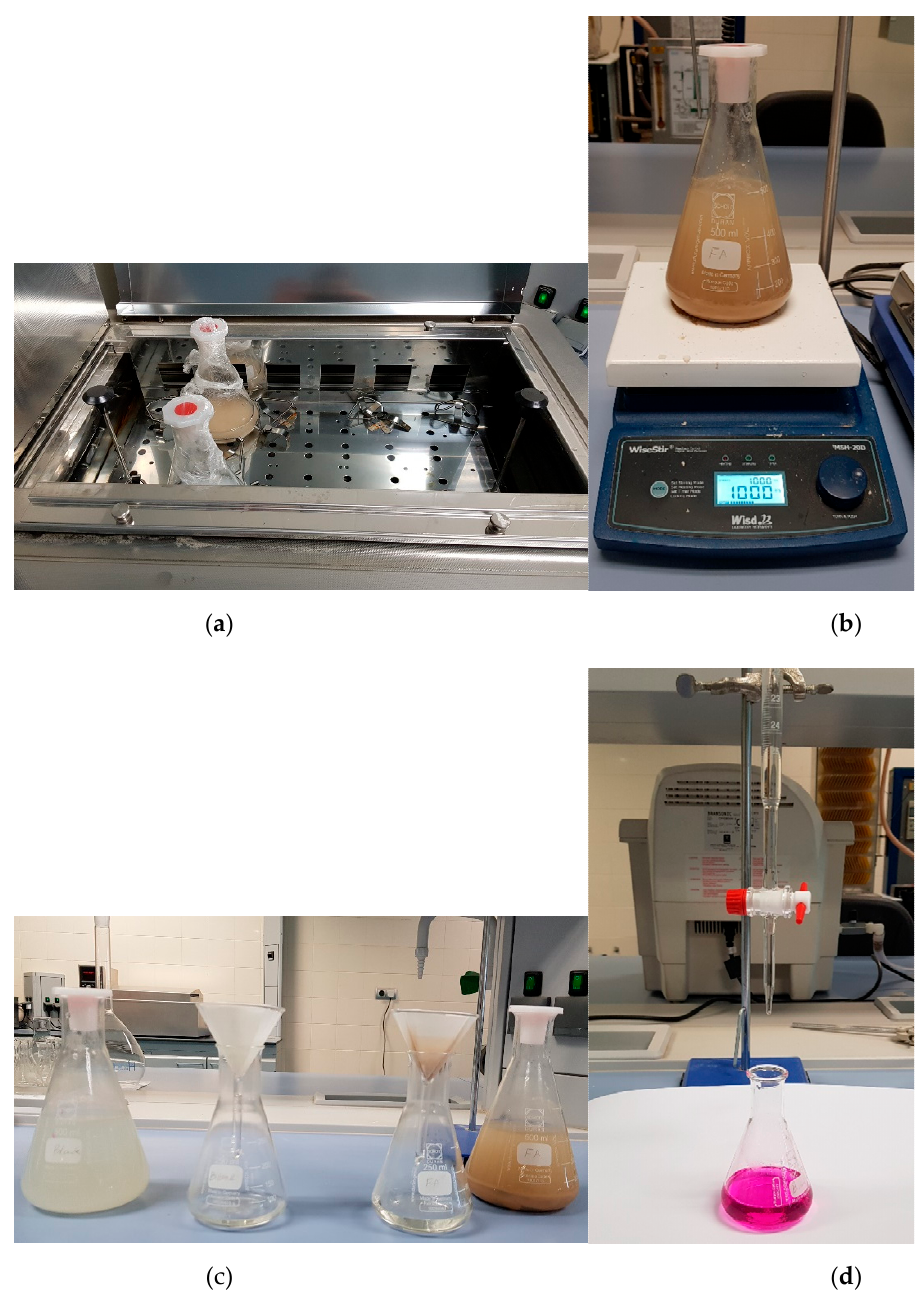
Figure 4. Illustration of the steps performed to determine Chappelle activity ( a ) Samples in the water bath, ( b ) Mixing (sucrose solution), ( c ) Filtration, and ( d ) Titration of the samples.